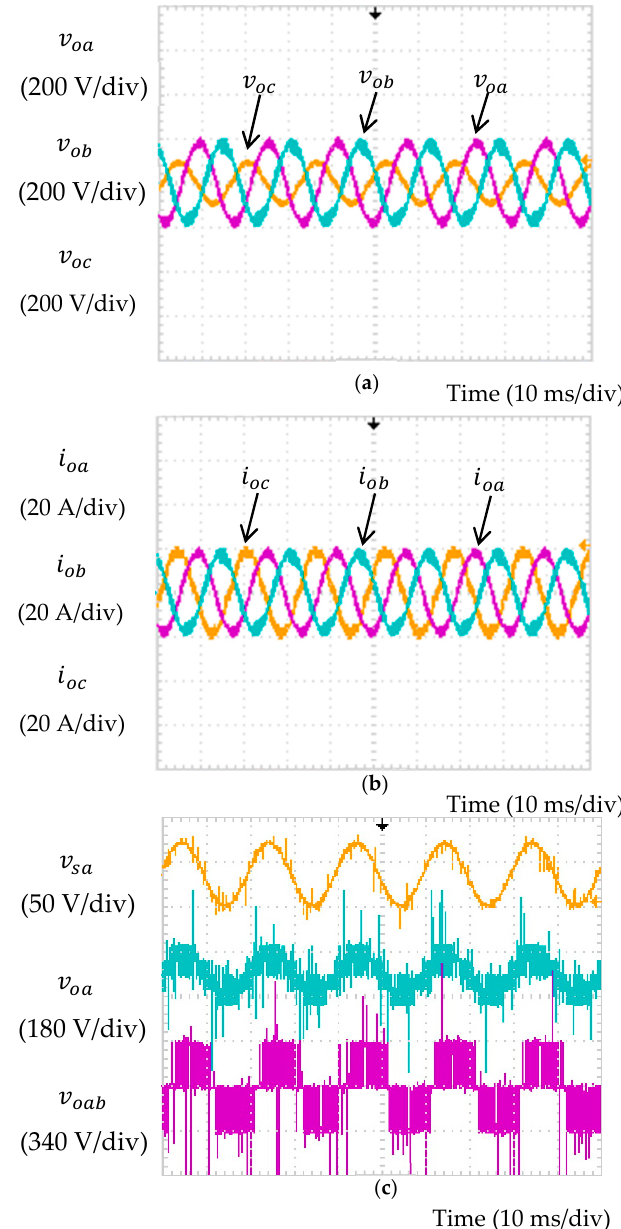
Figure 15. Measurement results of the three-phase input voltages and current: ( a ) input three-phase voltages, ( b ) input three-phase currents ( c ) three-phase voltage waveforms of AC fast charging.